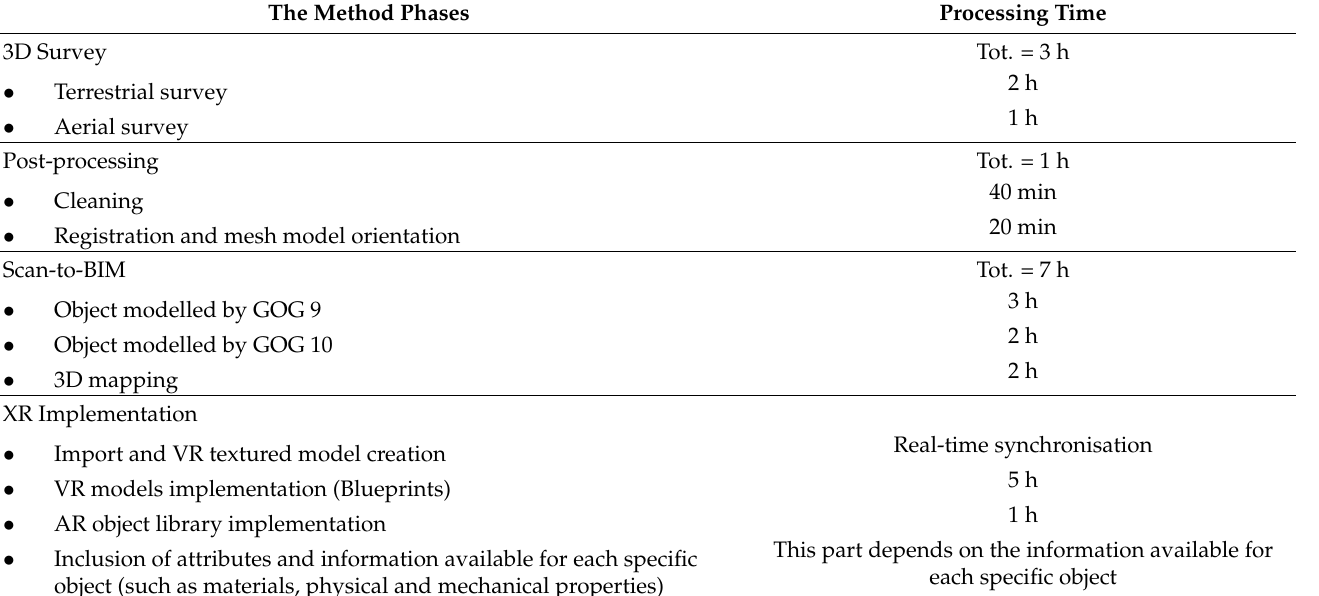
Table 3. Processing times in relation to the digital tools, software and exchange formats (output–input) to implement the workflow